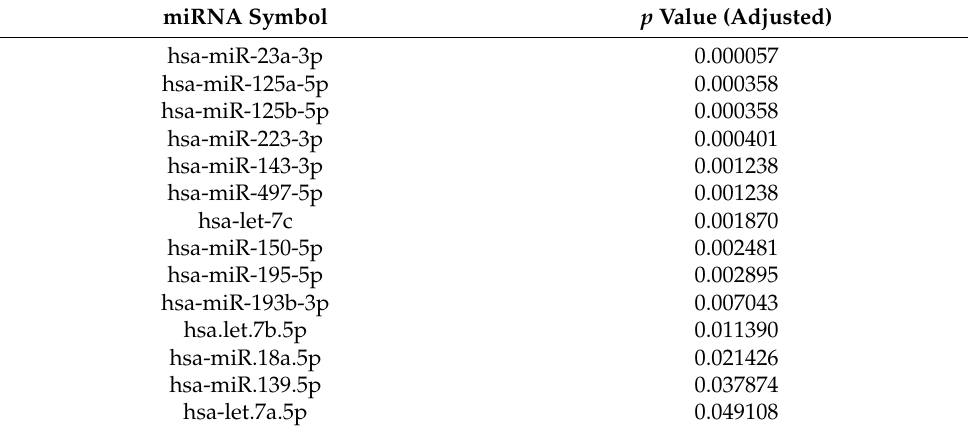
Table 2. miRNA candidates within LINC00152 -associated target